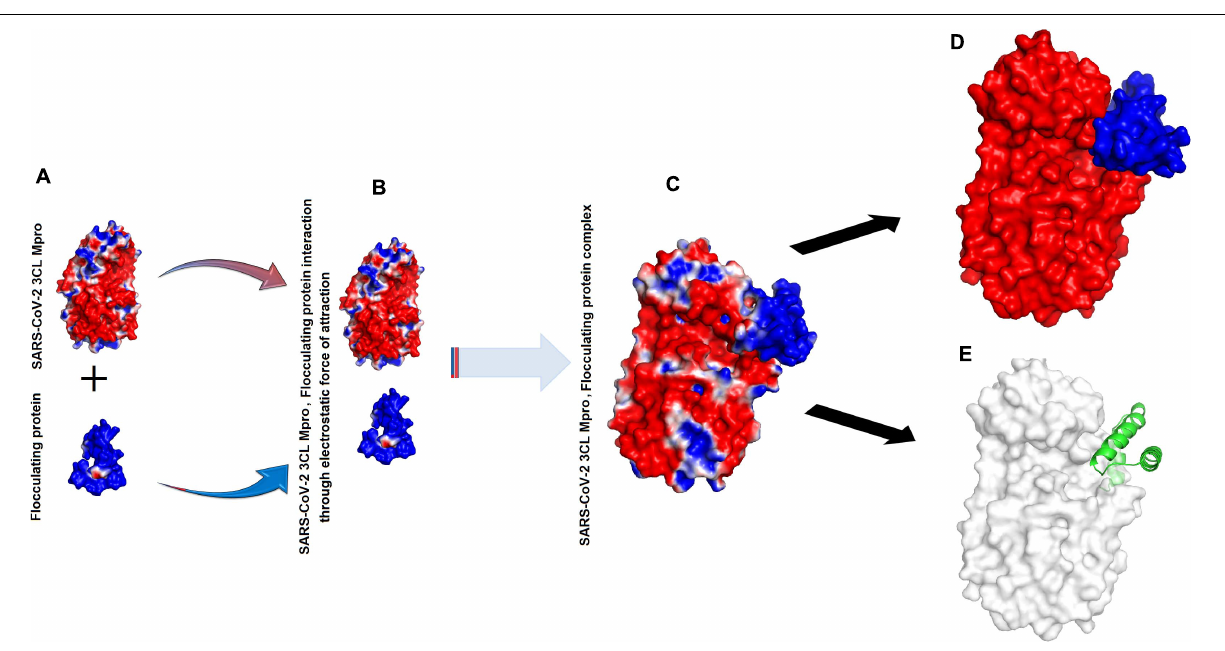
FIGURE 4 | Interaction between SARS-CoV-2 3CL M pro and flocculating protein: (A) Surface charge representation of SARS-CoV-2 3CL M pro and flocculating protein (B) SARS-CoV-2 3CL M pro and flocculating protein approaching each other (C) SARS-CoV-2 3CL M pro , flocculating protein complex (D) flocculating protein (shown as blue surface) residing in the cleft of SARS-CoV-2 3CL M pro between domains II and III (red colored) (E) flocculating protein (shown as green cartoon) interacting with SARS-CoV-2 3CL M pro (shown as white